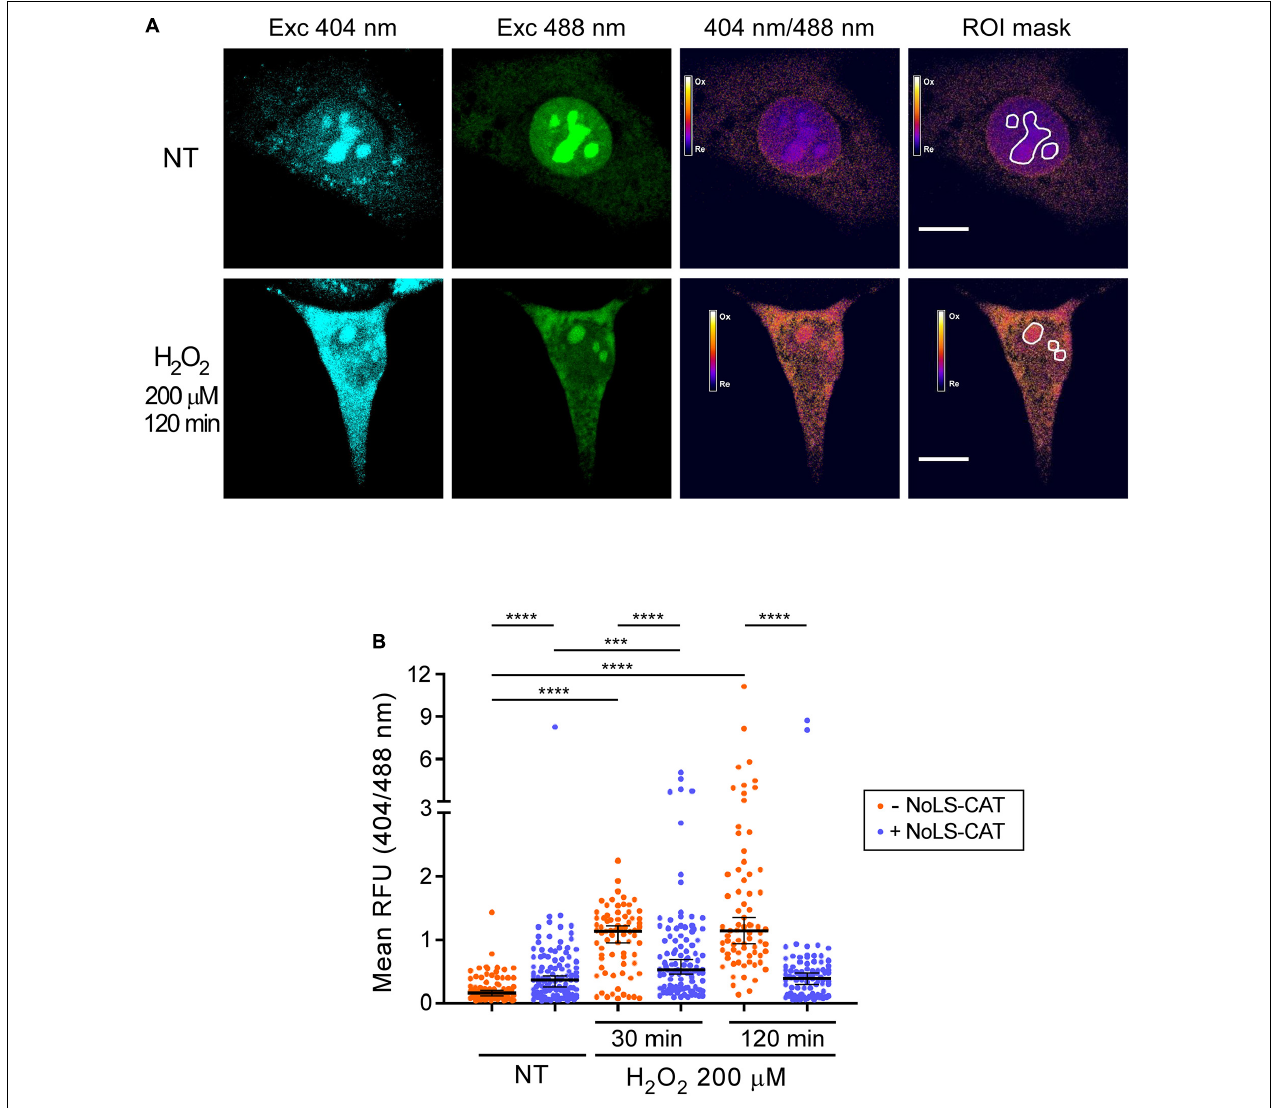
FIGURE 2 | H 2 O 2 promotes oxidation of the nucleolus. (A) Example of the ratiometric analysis of the nucleolar redox state. Live images of cells expressing NoLS-roGFP were taken before and after a 2 h treatment with 200 µ M H 2 O 2 . Emission at 515 nm was measured using the indicated excitation wavelengths to calculate the 404/488 nm excitation ratio of NoLS-roGFP. The white lines demarcate the Regions of Interest (ROIs) used to measure NoLS-roGFP signal in the nucleolus. Scale bars, 10 µ m. For an example of a wider microscopic field of the cells, see Supplementary Figure 2 . (B) Induction of NoLS-CAT counteracts the oxidation of the nucleolus induced with H 2 O 2 . The 404/488 nm excitation ratio of the nucleolar roGFP was measured in pNoROS-CAT-transfected pools grown either without Dox (–NoLS-CAT) or in the presence of 1 µ g/ml Dox for 24 h (+NoLS-CAT) prior to the indicated H 2 O 2 treatments. For each set of conditions, 70–110 nucleoli from a total of 30–40 cells were analyzed. The horizontal line represents the median, error bars show 95% CI. Statistical significance was assessed by pairwise Mann-Whitney tests. **** P < 0.0001, *** P < 0.001 (two-tailed